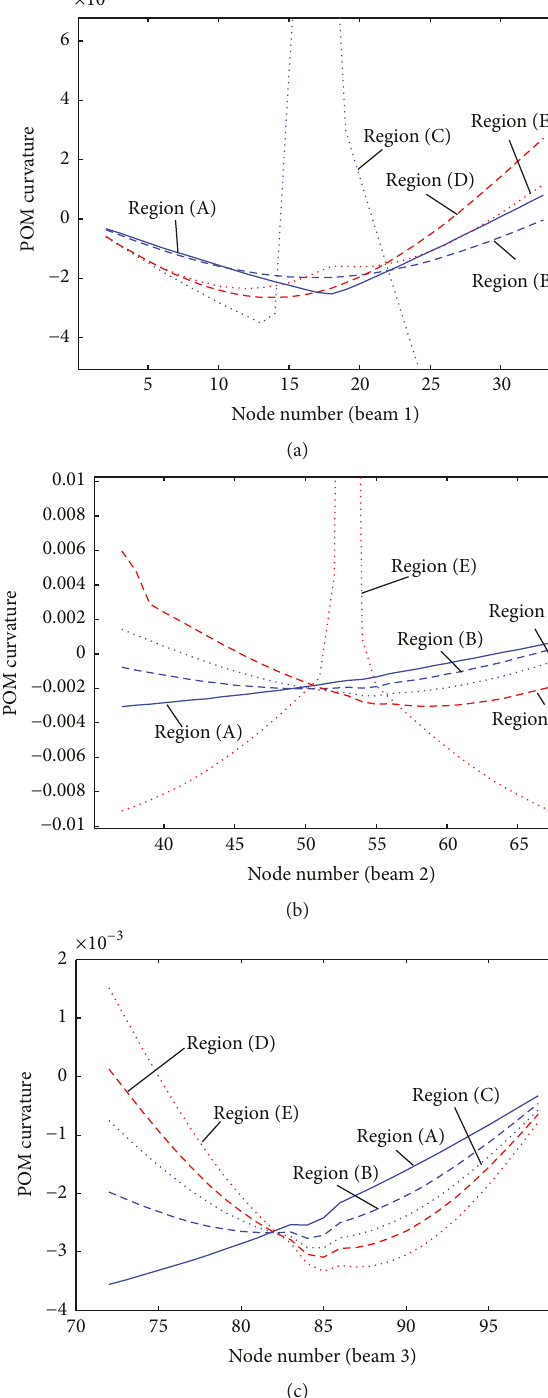
Figure 5: POM curvature curves using noise-free FRFs: (a) beam 1, (b) beam 2, and (c) beam 3. with the increase of the frequency region to extract the FRF data. It is found that the plots in Figure 4 do not provide the information on the damage in the beam. Figure 5 exhibits the POM curvature curves approx- imated numerically using the central difference